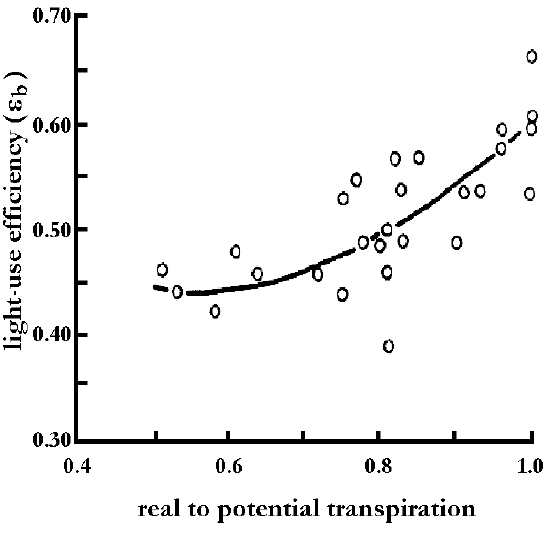
Figure 5. Dependence of  Atzberger